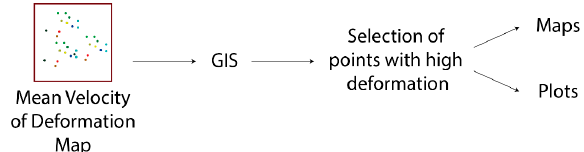
Figure 4. Workflow (iii): Analysis of deformation maps within a geographic information system (GIS) with creation of plots to understand the deformation of areas of interest (AOIs).